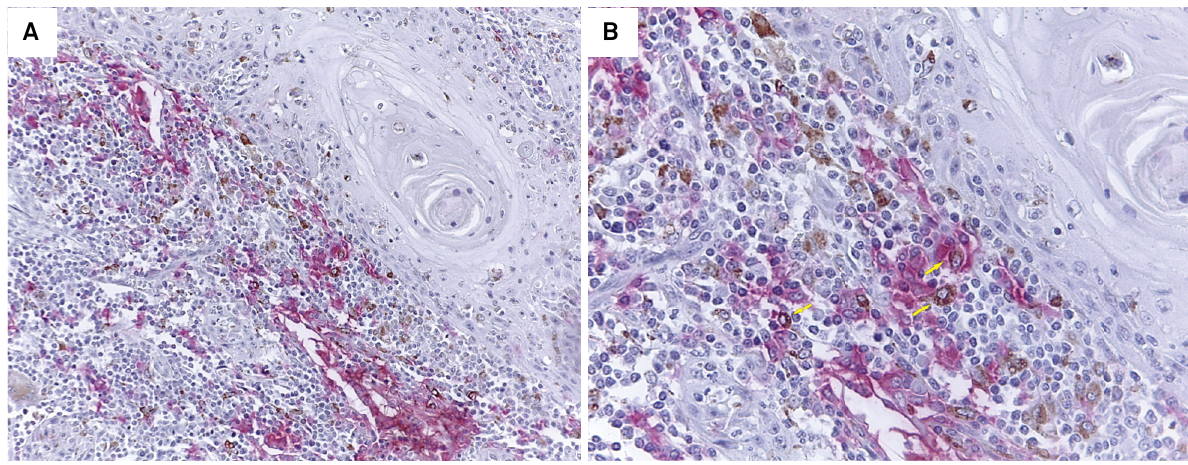
Figure 1. (A) Invasive front of SCCLL exhibiting CD68+ (brown staining) and HLA-DR+ (red staining) cells (EnVision, 200×). (B) M1 TAMs (arrows) double stained with anti-CD68 and anti-HLA-DR antibodies (EnVision, 400×).